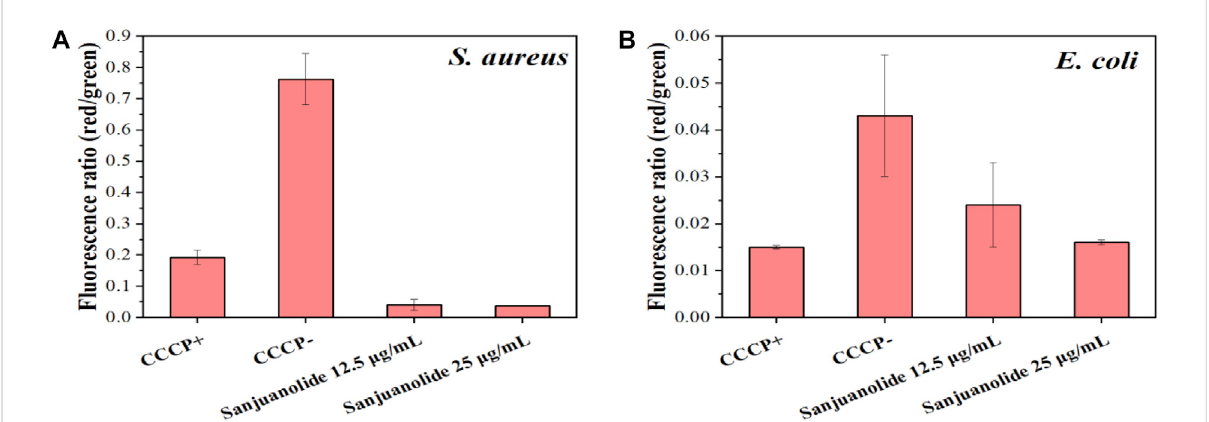
FIGURE 7 Ratioofred/green fl uorescenceintensitiesof S.aureus CMCC26003 (A) and E . coli CMCC44102 (B) underthedifferenttreatments,whichwere calculated using the